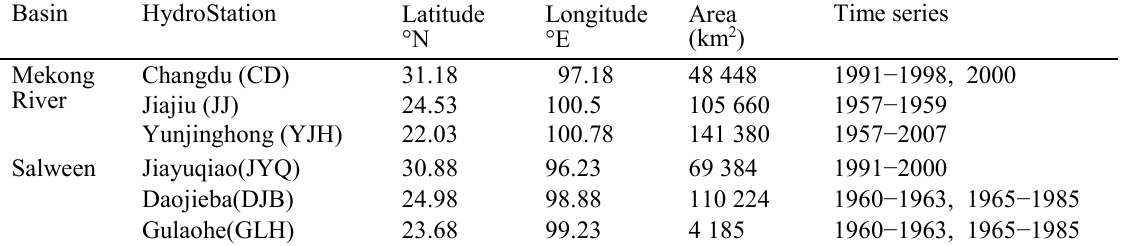
Table 1 List of hydrological stations and their features. Basin